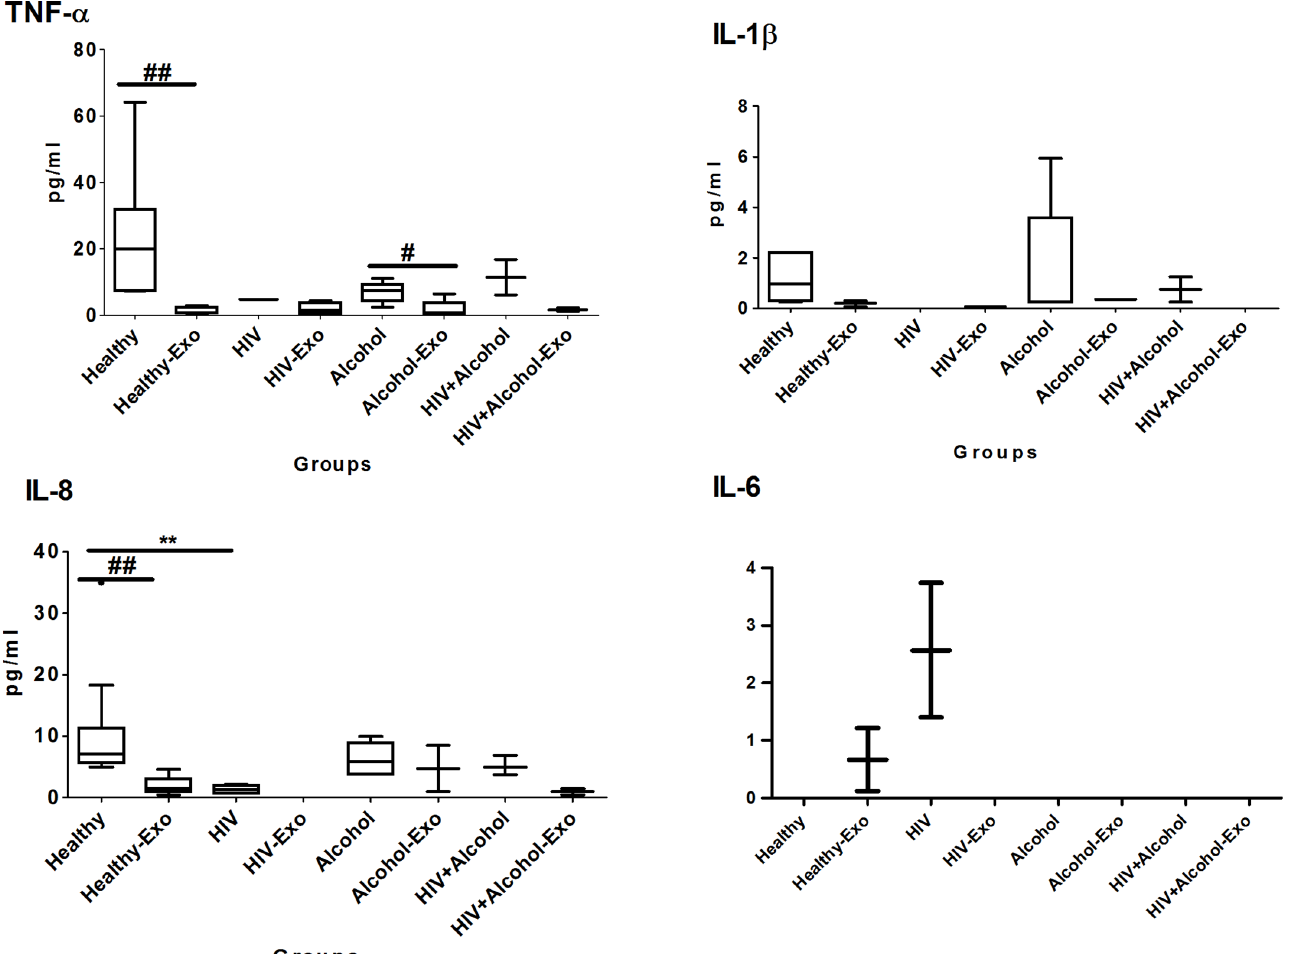
Fig 1. Box and whisker plots of pro-inflammatory cytokines between HIV-negative non-drug abusers (healthy), HIV-positive non-drug abusers (HIV), HIV-negative alcohol drinkers (alcohol), and HIV-positive alcohol drinker (HIV+alcohol) subjects. The box represents the 25 th -75 th quartile, the whiskers represent the range of values, the median is presented as a line inside the box, and the out–of-range values are presented as circles. Mann–Whitney U test was used to compare between the plasma and their respective exosomes of different study groups, and significant p-values are represented as #(p (cid:20) 0.05) and ## (p (cid:20) 0.01). Comparison of cytokine levels among plasma as well as exosomes of different groups were done using Mann–Whitney U test, and significant p-values are given as (cid:3) (p (cid:20) 0.05), (cid:3)(cid:3) (p (cid:20) 0.01) and $(p (cid:20) 0.05), $ $((p (cid:20) 0.01), respectively.